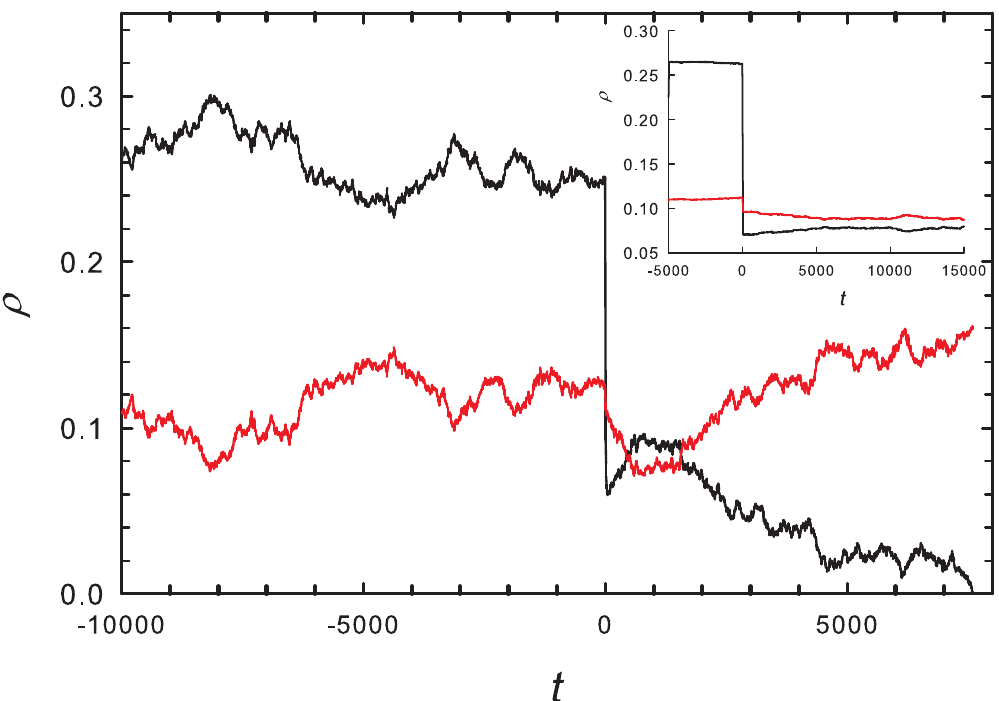
Fig 4. MF equations with additive noise. Main graph shows the densitiesof the fast and slow species (black and red curves, respectively) versus time; at time zero the reproduction rate λ is reducedfrom 1.6 to 1.2. Other parameters: α = 0.1, γ = 0.01. Inset: averagedensitiesin a sample of 500 independent realizations.